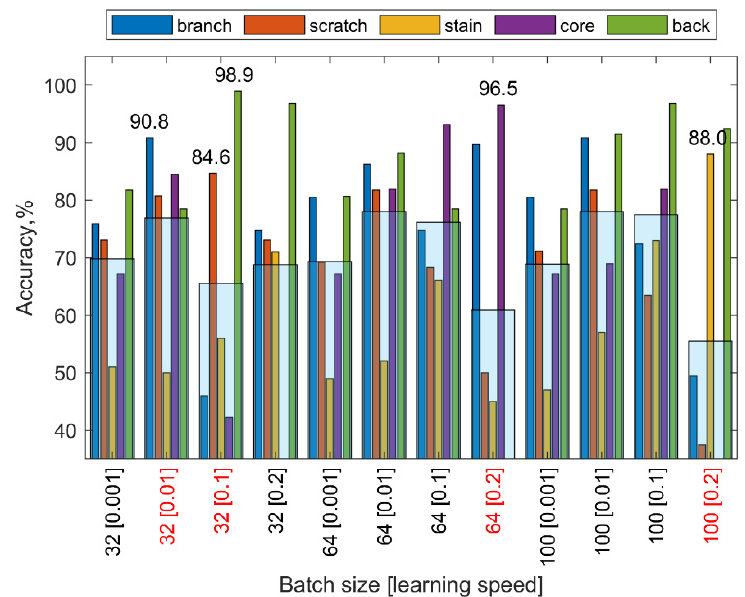
Figure 14. Classification accuracy using VGG16 neural network trained with different network parameters (batch size and learning speed). The best combinations of parameter values are indicated in red.